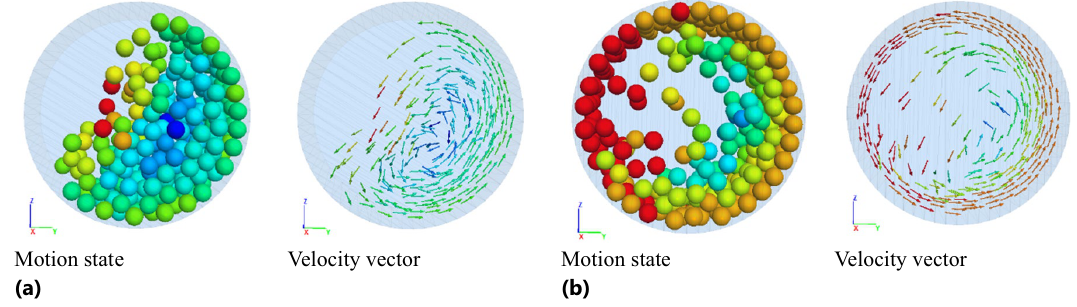
Figure 24. Motion state and velocity vector of particles: (a) n = 90 r/min (b) n = 120